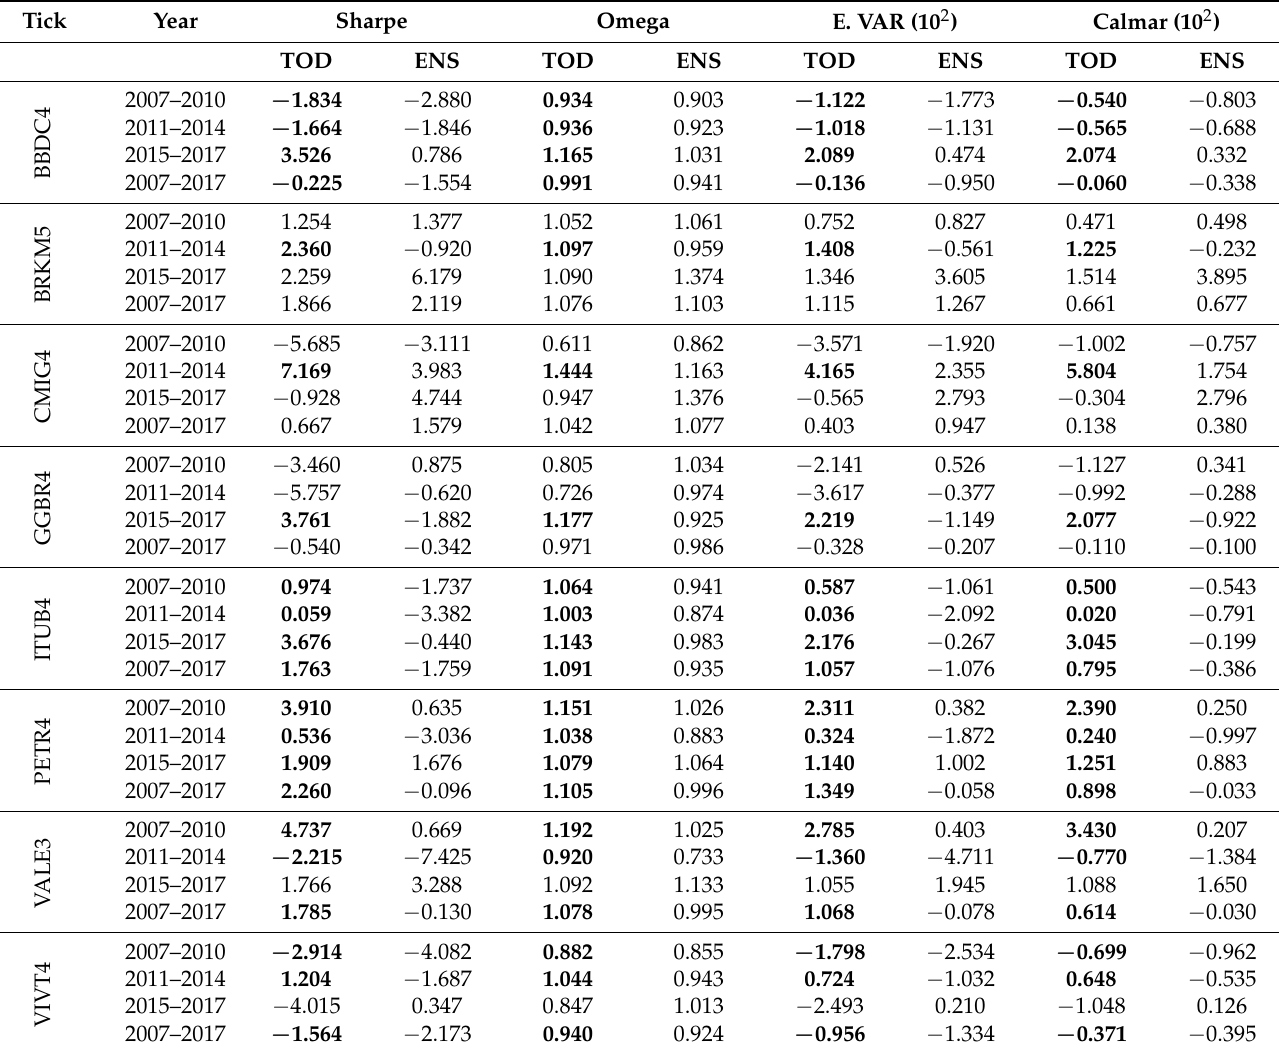
Table 3. Performance metrics: risk-adjusted. (By the authors.) The results in which the performance of the TOD model is superior to that of the ENS are